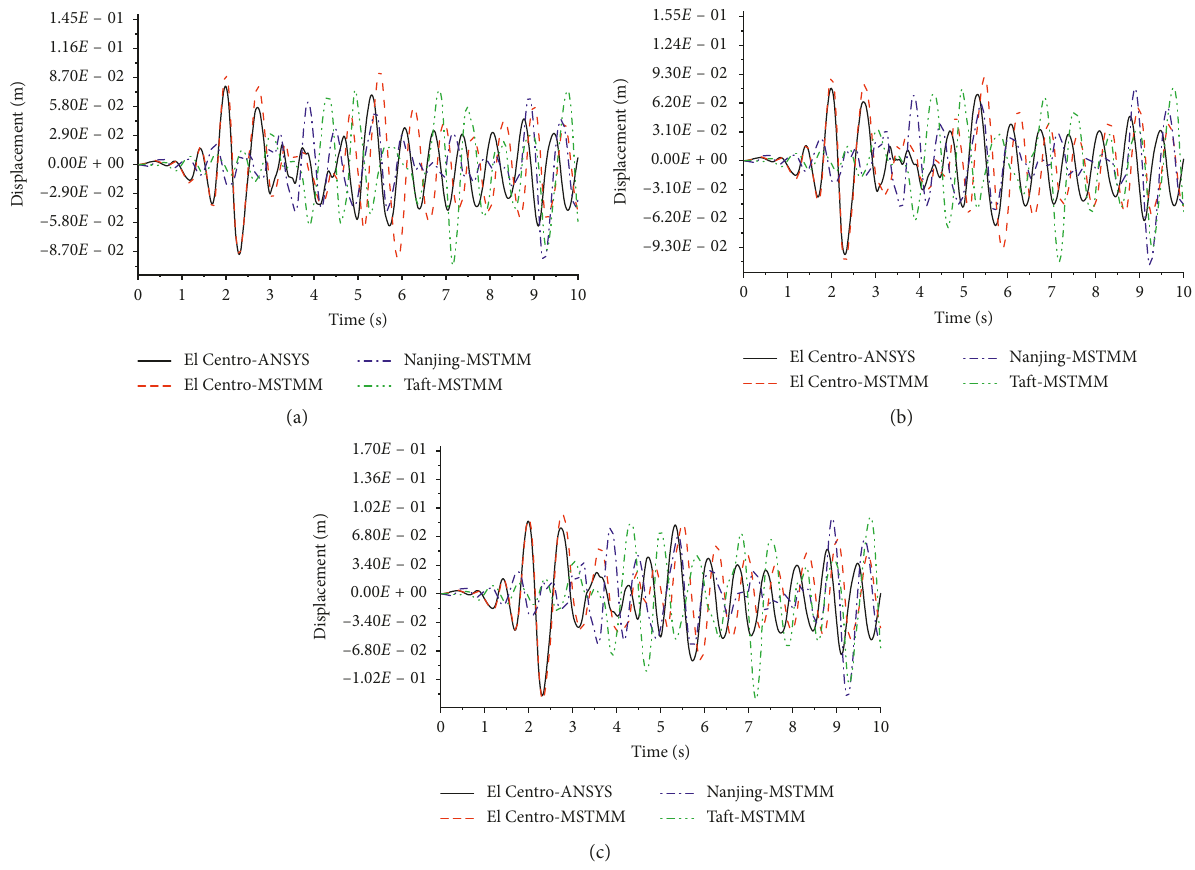
2 ). (a) 100mm,(b) 130mm, and